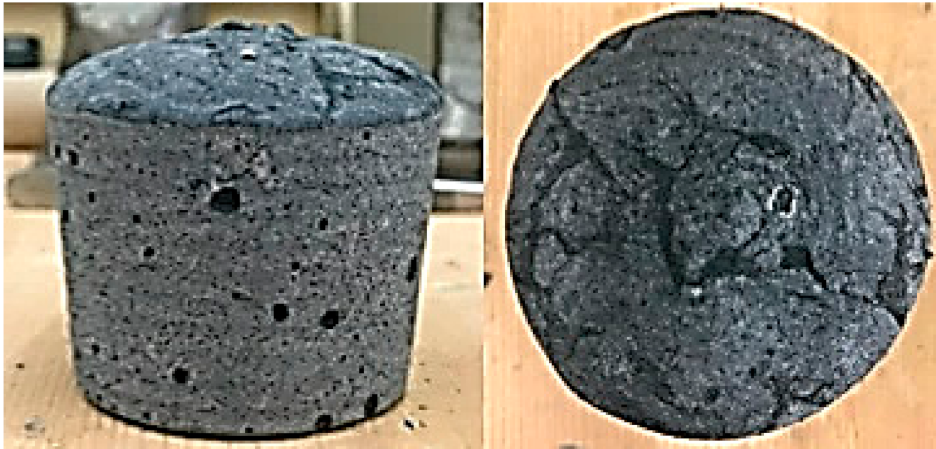
Figure 3. 50MK-50IBA + 70%Biochar at 90 curing